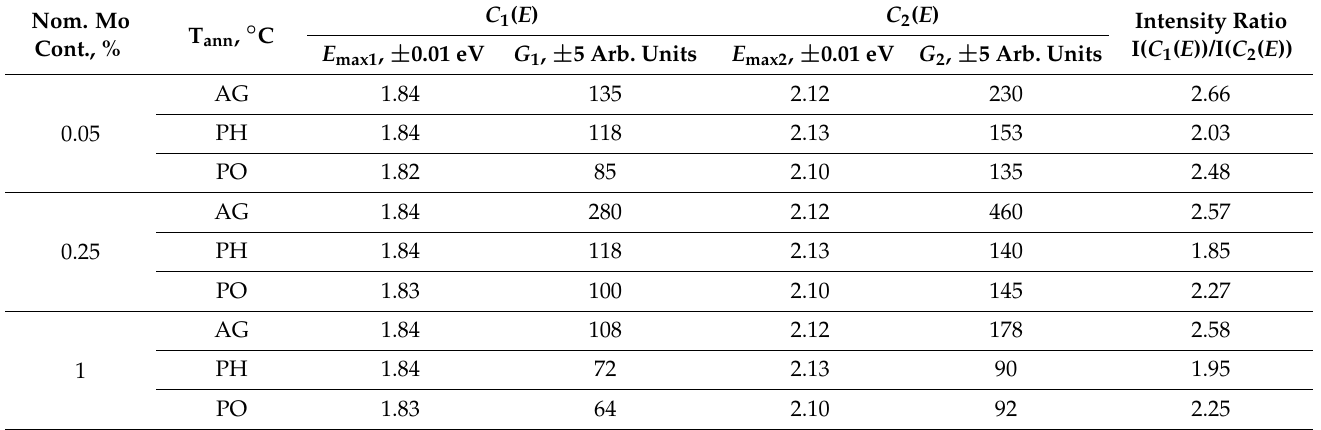
Table 2. E max1,2 and G 1,2 of the Gaussian components ( C 1,2 ( E ) ) for each kind of treatment.